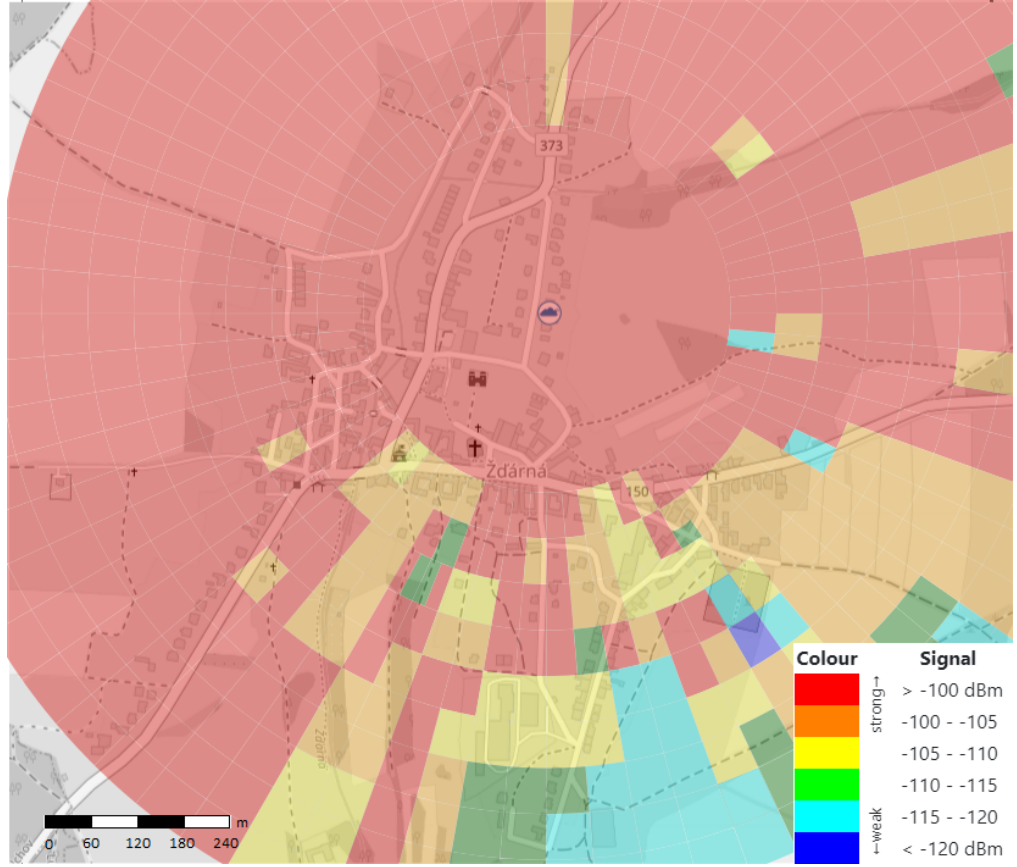
Figure 13. Heat map of the signal coverage in scale